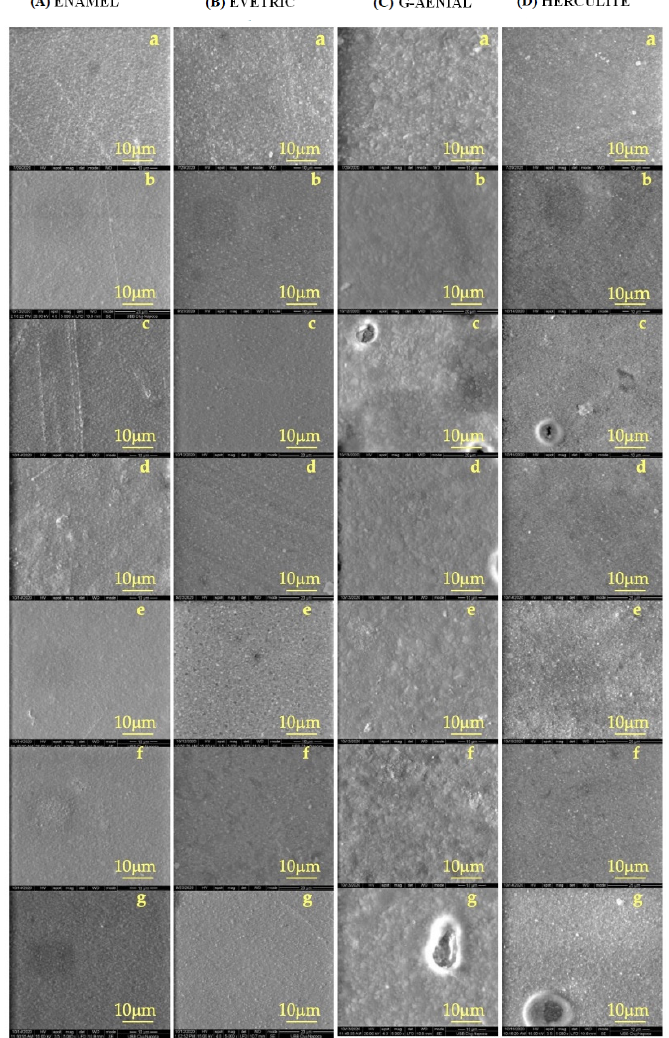
Figure 3. SEM images for dental composites: ( A ) Enamel, ( B ) Evetric, ( C ) G-aenial, and ( D ) Herculite exposed to various saliva: ( a ) untreated sample, ( b ) healthy, ( c ) artificial, ( d ) AML, ( e ) CML, ( f ) ALL, ( g )